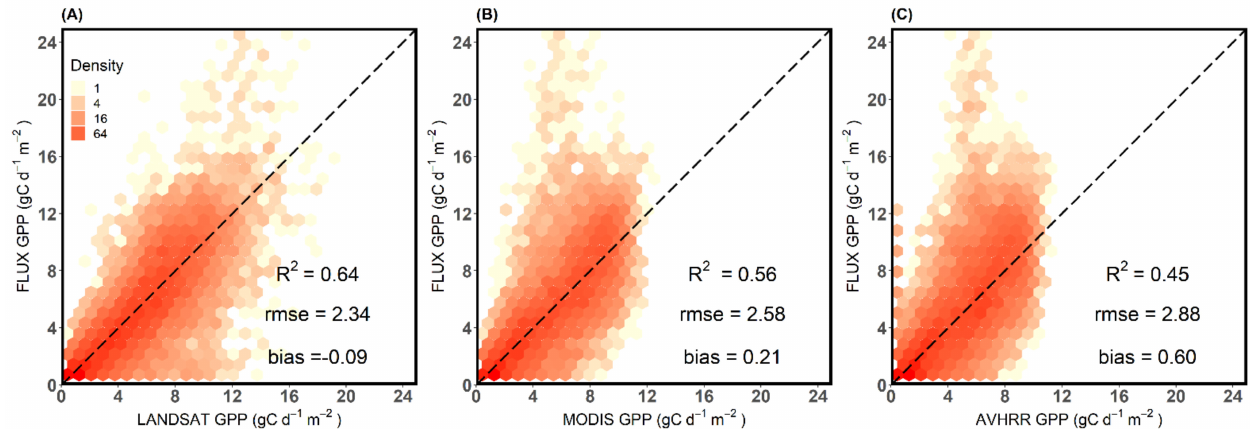
Figure 3. Three-spatial-resolution GPP data compared to GPP observed at flux sites. The three series of GPP data: Landsat ( A ), MODIS ( B ), and AVHRR ( C ) were consistent with the date at 16-day intervals. The dashed line is the 1:1